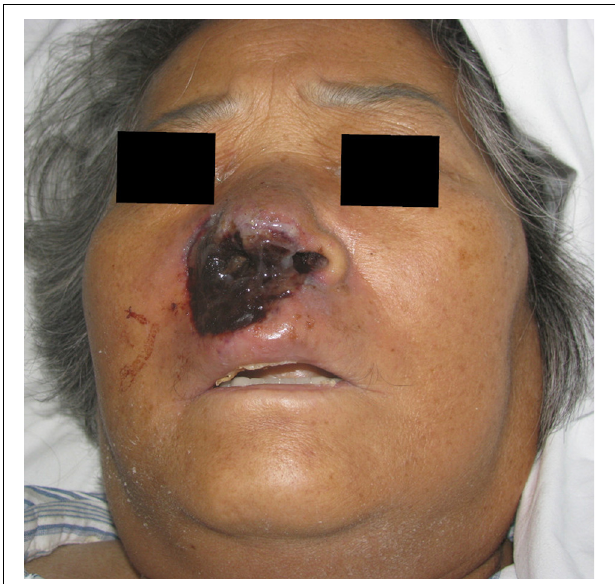
FIGURE 1 | Image of patient exhibiting edematous erythema, ulcer, and necrosis over the right nasal alae and upper lip.